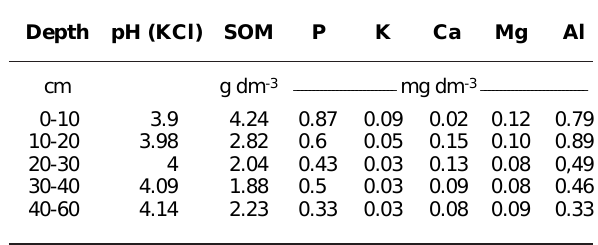
Table 2. Values of pH, soil organic matter (SOM), extractable-P and exchangeable-K, Ca, Mg and Al in down to 60 cm deep soil layers. (Source: Ferreira et al., 2001)